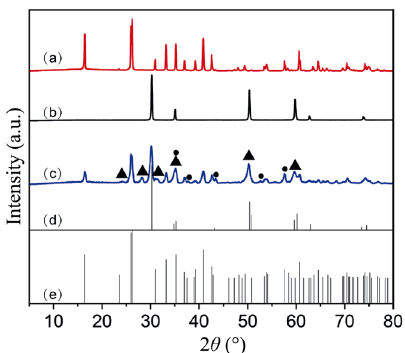
Fig. 8 XRD patterns of (a) mullite powder, (b) YSZ powder, (c) 20 wt% YSZ/mullite hollow fiber membranes sintered at 1630 ℃ , respectively, (d) tetragonal ZrO 2 standard and (e) mullite standard ( ▲ : monoclinic ZrO 2 , •:  -Al 2 O 3